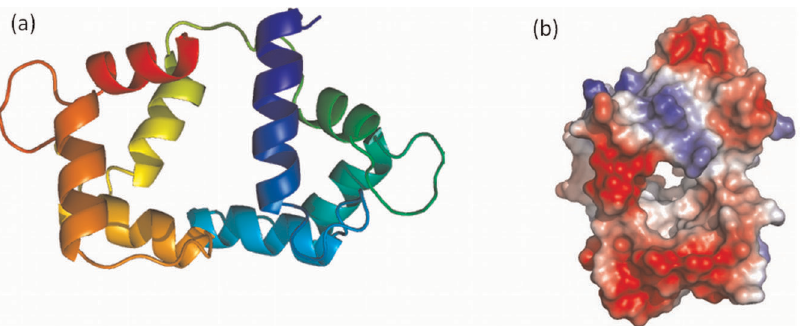
Figure 1. Homology modelled CaM-like protein. (a) Cartoon representation of model of CaM-like protein. The N& C terminal is dark blue and dark red respectively (b) Electrostatic molecular surface representation of the model of CaM-like protein.